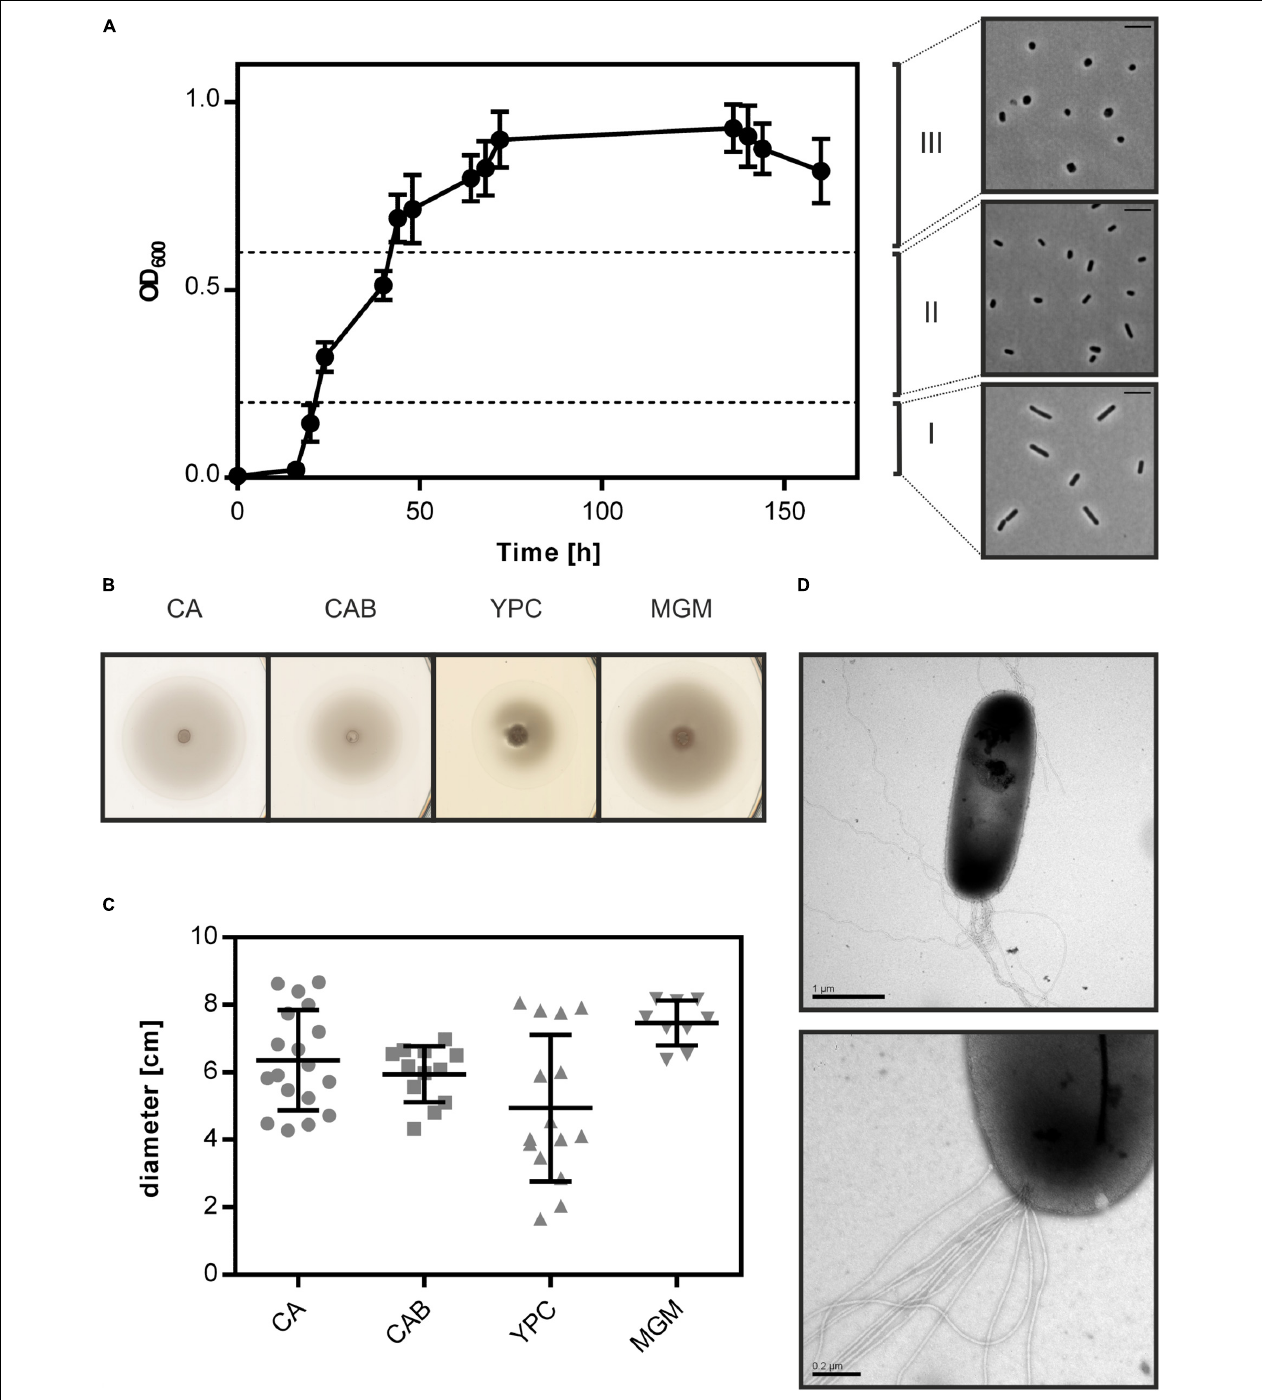
FIGURE 1 | Cell shape change and motility of Hfx. gibbonsii LR2-5. (A) Left side: typical growth curve of Hfx. gibbonsii LR2-5 in CA medium with 18% (wt/vol) SW at 42 ◦ C. Average optical density at 600 nm (OD 600 ) was calculated from three independent technical replicates; error bars represent the standard deviation. Right side: phase contrast images show typical cell shapes correlating with three different growth phases: early exponential (I), mid-exponential (II), and stationary (III) growth phases. (B) Representative example of motility rings from Hfx. gibbonsii LR2-5 on semi-solid agar plates with different media after 3 days of growth at 45 ◦ C. (C) Quantification of the diameter of motility rings formed on semi-solid agar plates with different media in 18% SW. Calculations were made using more than three independent experiments including three biological replicates each. Middle line indicates the mean, and lower and upper lines the standard deviation. (D) Cells from early exponential growth phase were negatively stained with 2% (wt/vol) uranyl acetate. Top: Hfx. gibbonsii LR2-5 cell with typical rod-shaped morphology and archaella at the cell pole. Scale bar, 1 µ m. Bottom: Close up of a bundle of archaella filaments at the cell surface. Scale bar, 0.2 µ m.